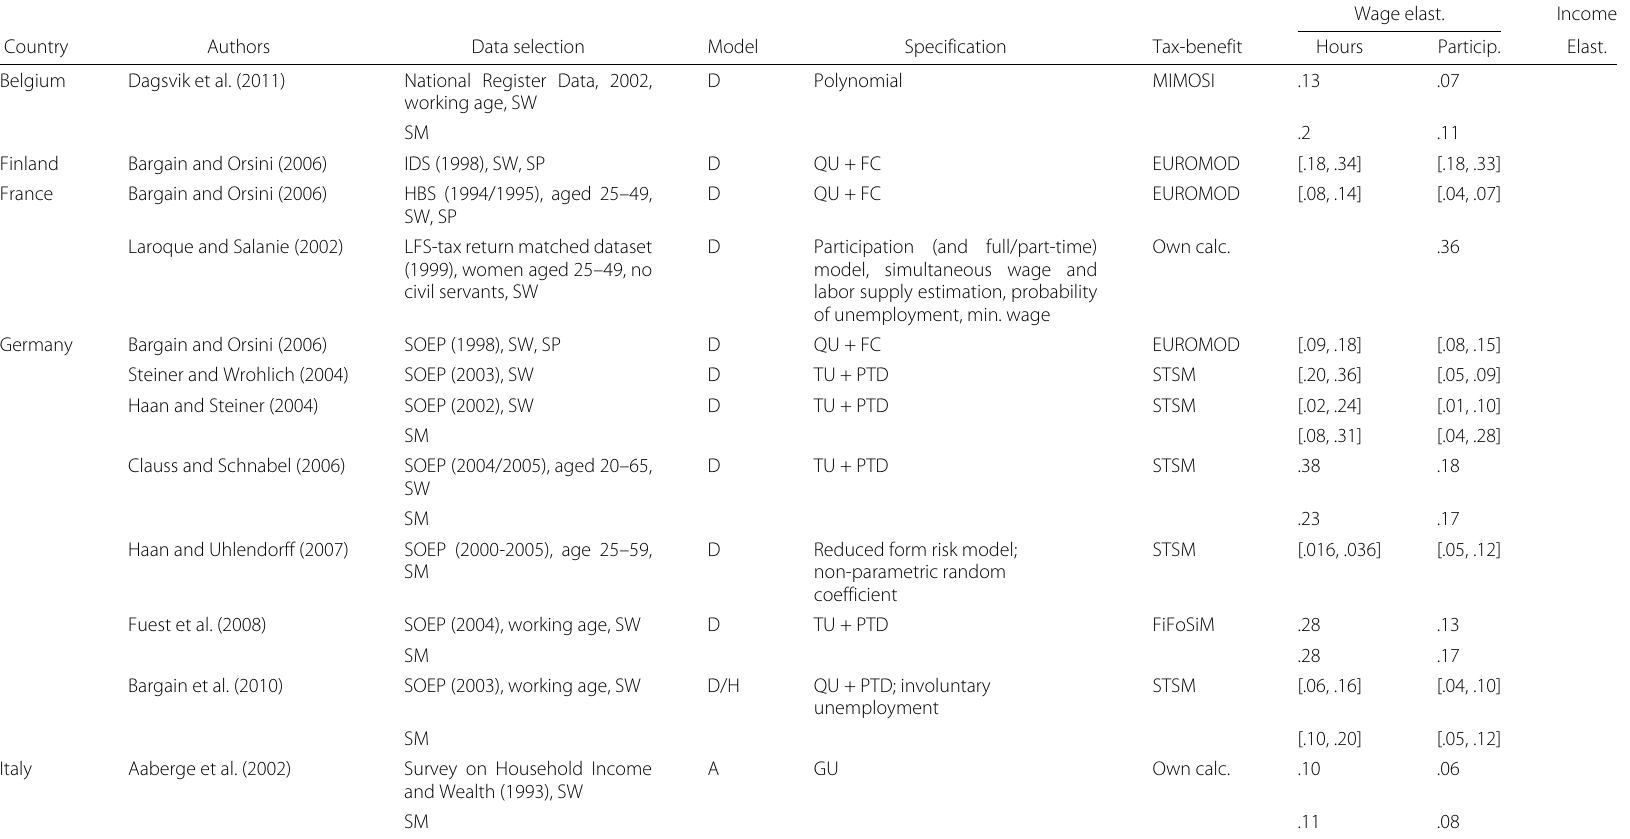
Wage elast. Income